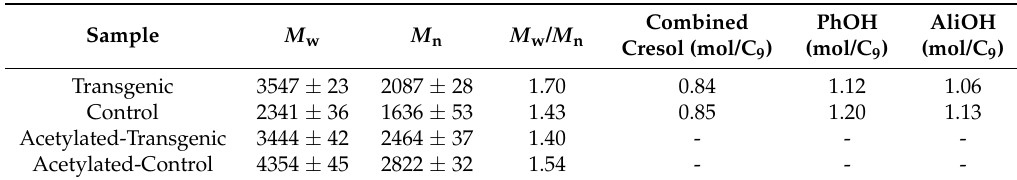
Table 2. Molecular weight and functional groups of LCs.